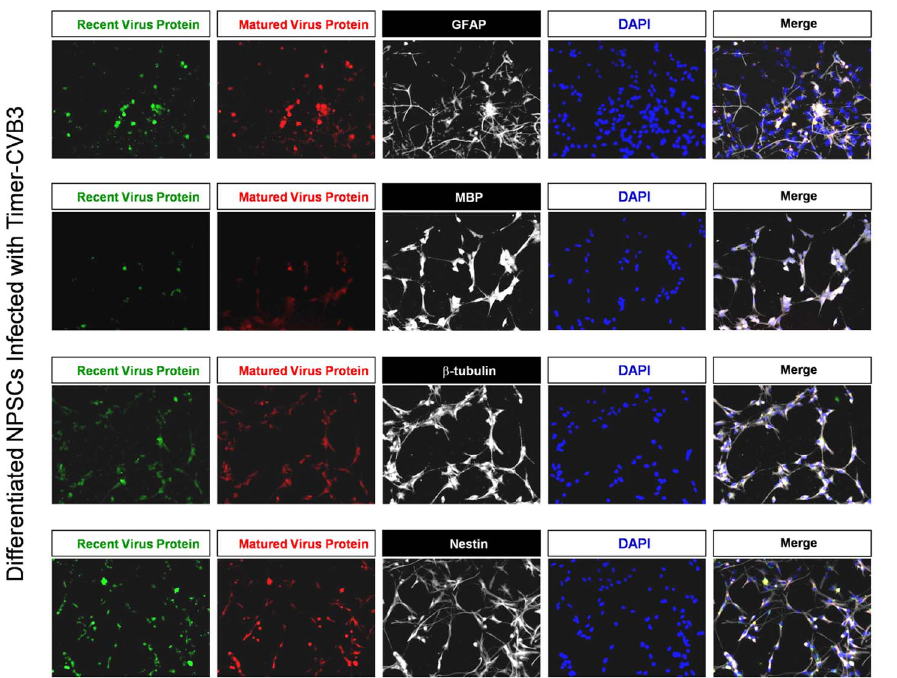
Figure 6. Inspection of recent and matured virus protein expression in differentiated NPSCs infected with Timer-CVB3. NPSCs cultures were differentiated for five days, and then infected with Timer-CVB3 for three days, followed by immunostaining for lineage markers (white signal). ‘‘Fluorescent timer’’ protein produced early on (matured virus protein) marked cells which were infected early on. Newly infected cells were distinguished by green fluorescence (recent viral